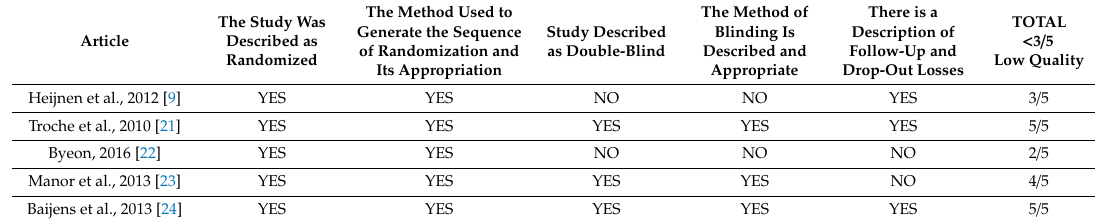
Table 3. Risk of bias. Application of the Jadad scale to the clinical trials of this